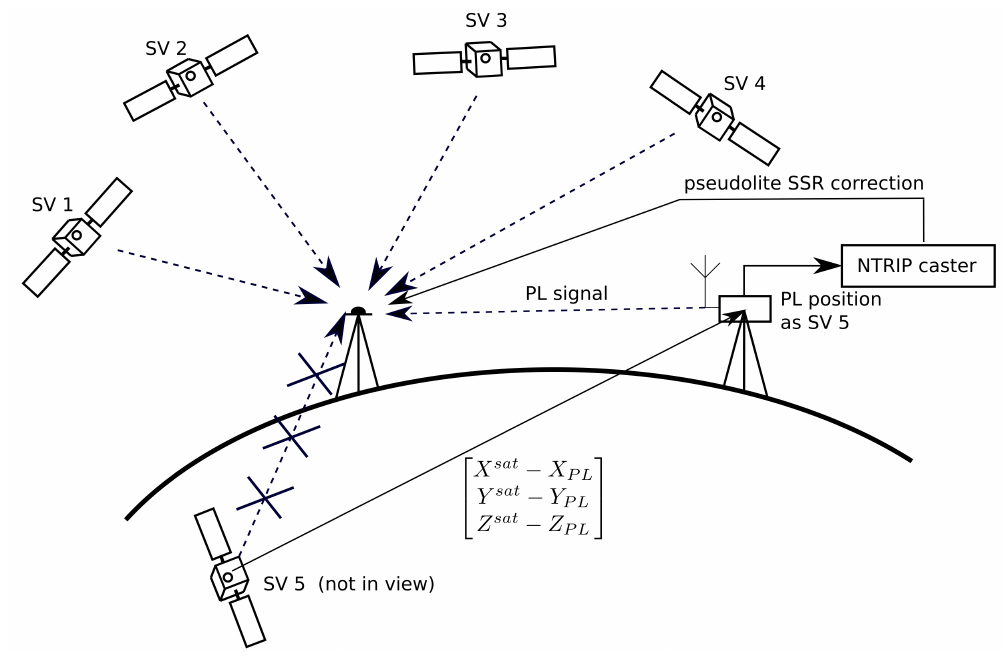
Figure 2. Idea of SSR satellite–pseudolite